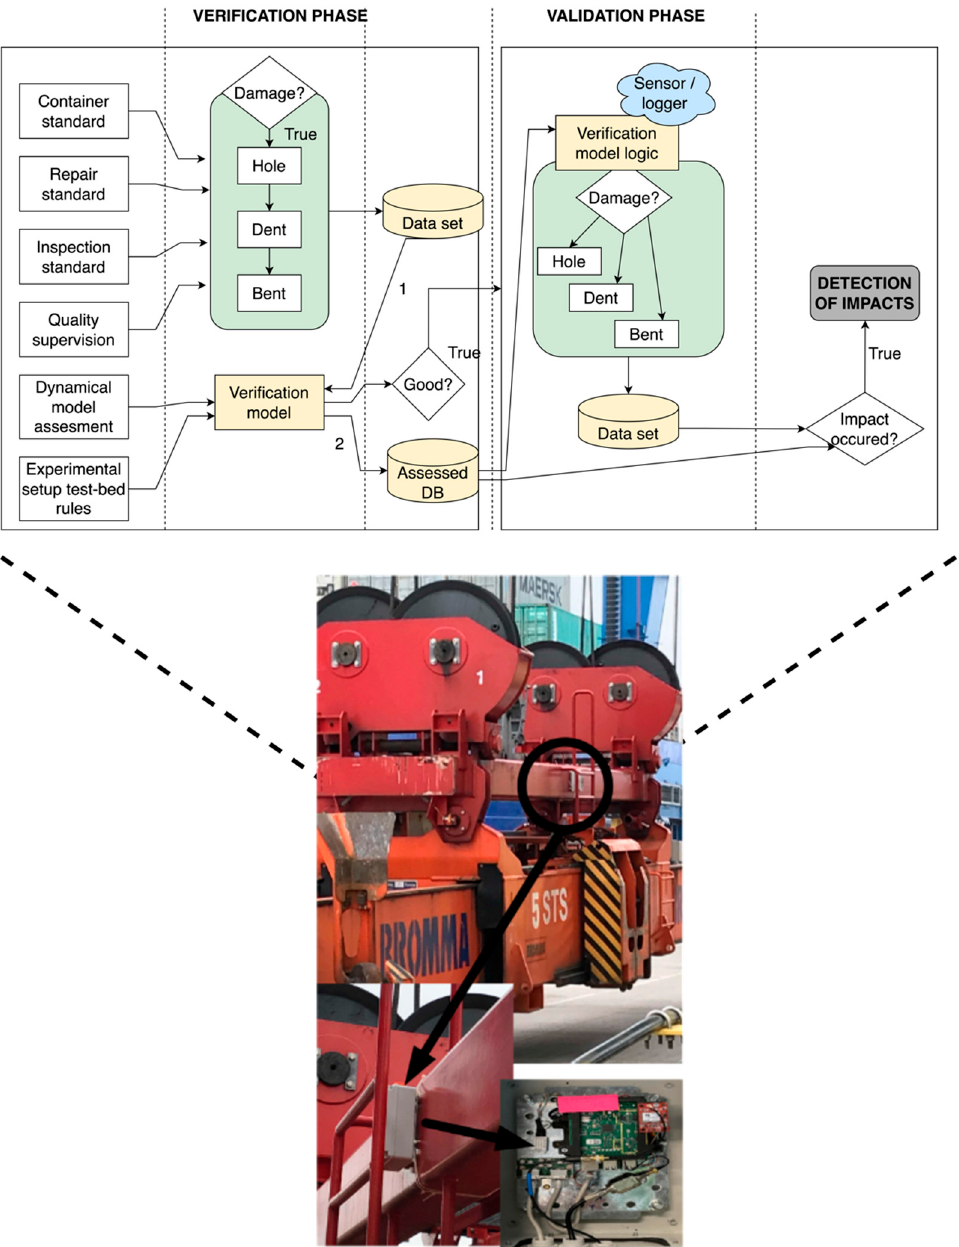
Figure 7. The high-level schematic of the process of data collection using the IoT sensor for VCG damage detection, using the frequency threshold detection method (refer to Figures 4–6), and the visual inspection